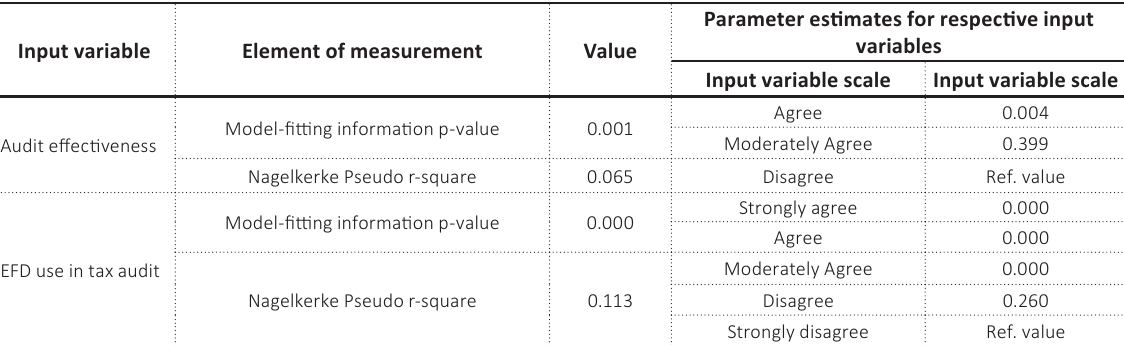
Table 9. Ordinal regression between different variables and tax